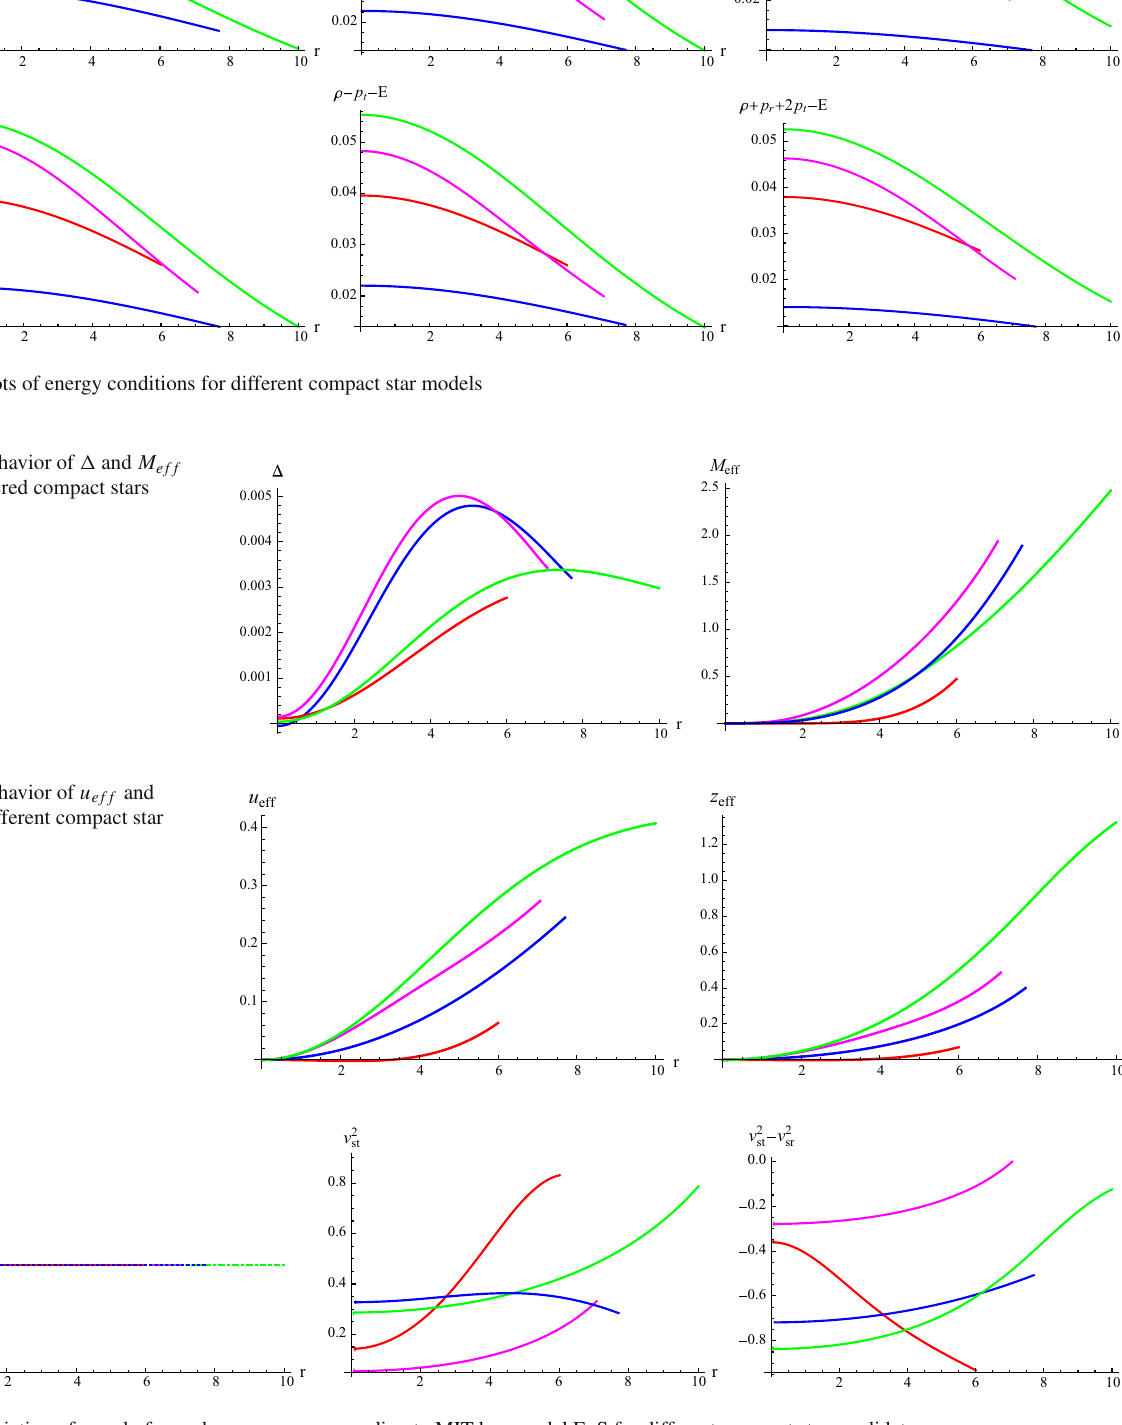
Fig. 5 Variation of speed of sound versus r corresponding to MIT bag model EoS for different compact star